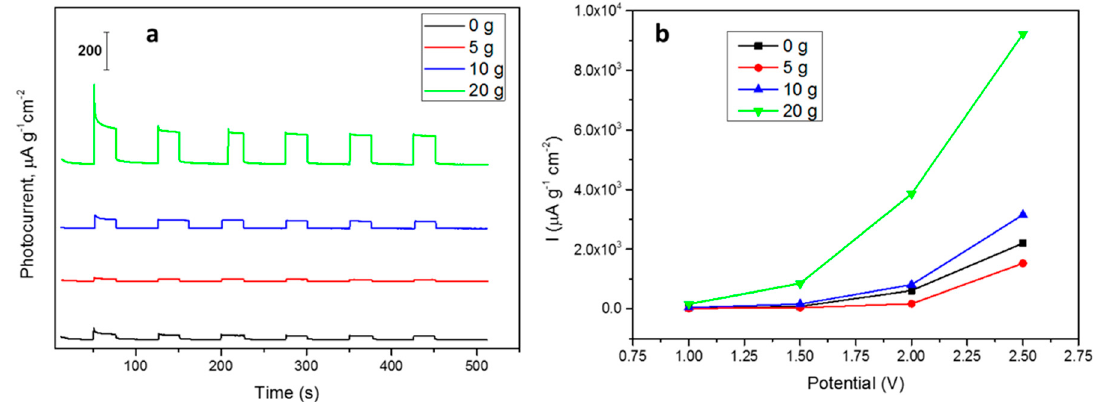
Figure 7. ( a ) Photocurrents measured for the synthesized materials at 1 V imposed and ( b ) trends of the photocurrents at the four imposed potentials (1, 1.5, 2 and 2.5 V).